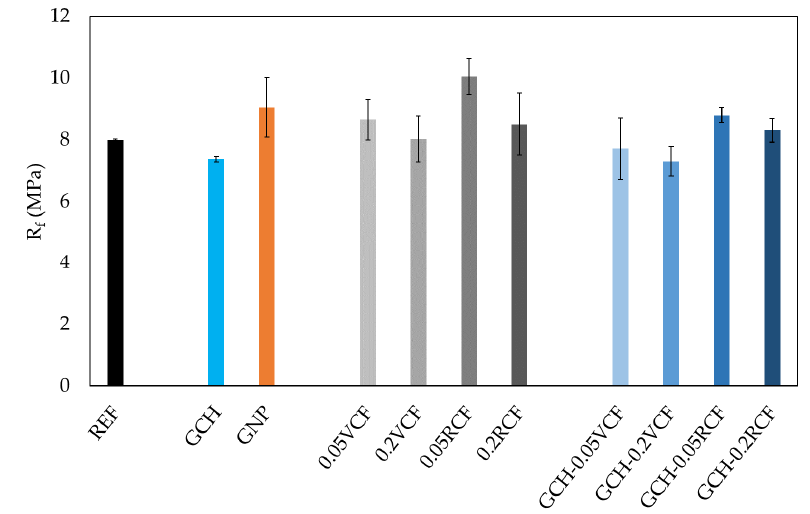
Figure 6. Flexural strength (R f ) of mortars after 28 days of curing.